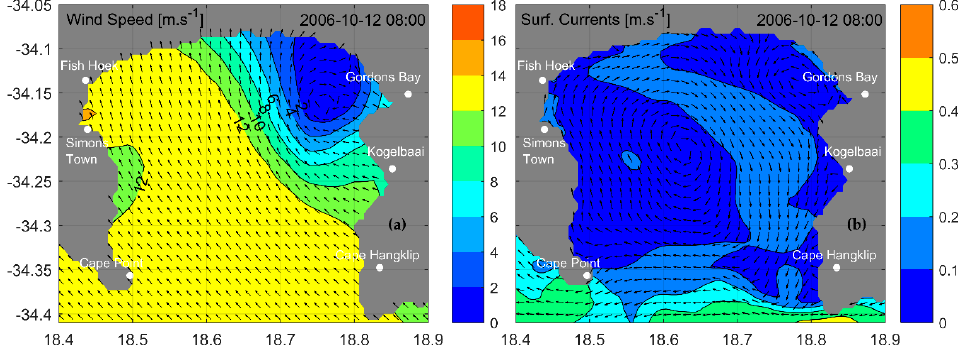
Figure 9. Cyclonic flow in False Bay ( b ) permitted to develop as a result of the wind shadow in the north-eastern margins of the Bay ( a ).